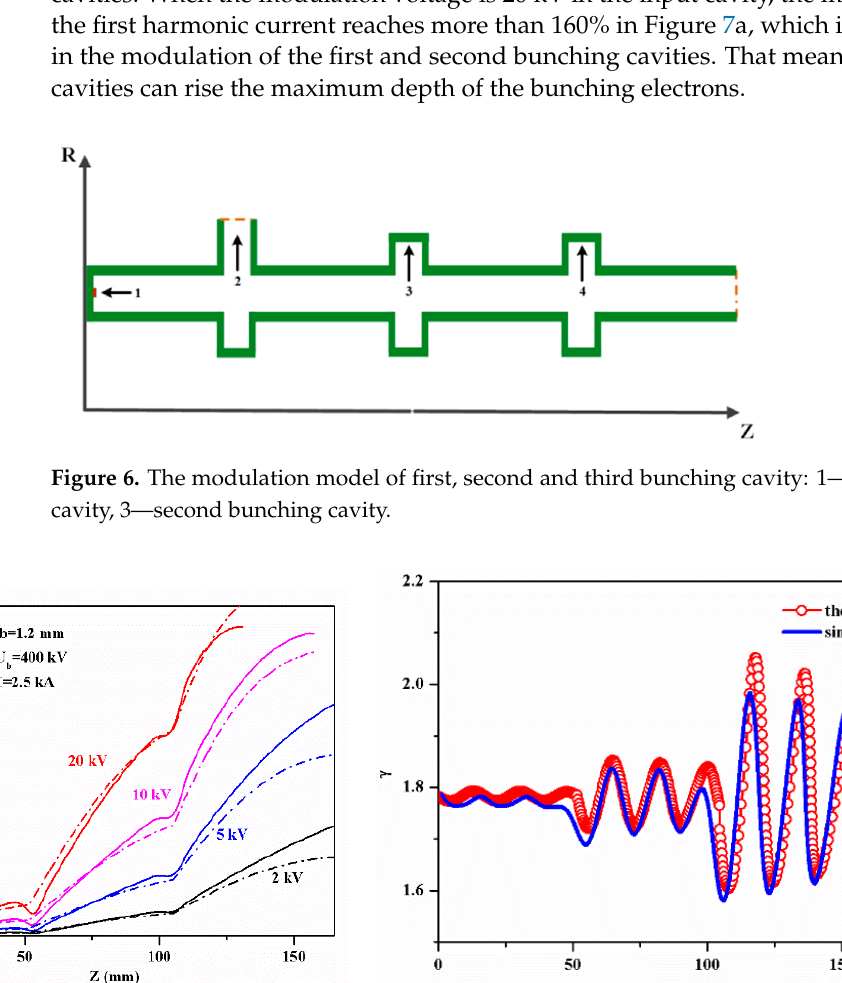
Figure 7. ( a ) The first harmonic current versus different modulation voltage: full lines show theoretical results while dotted lines show simulation results. ( b ) The velocity dispersion versus displacement Z.